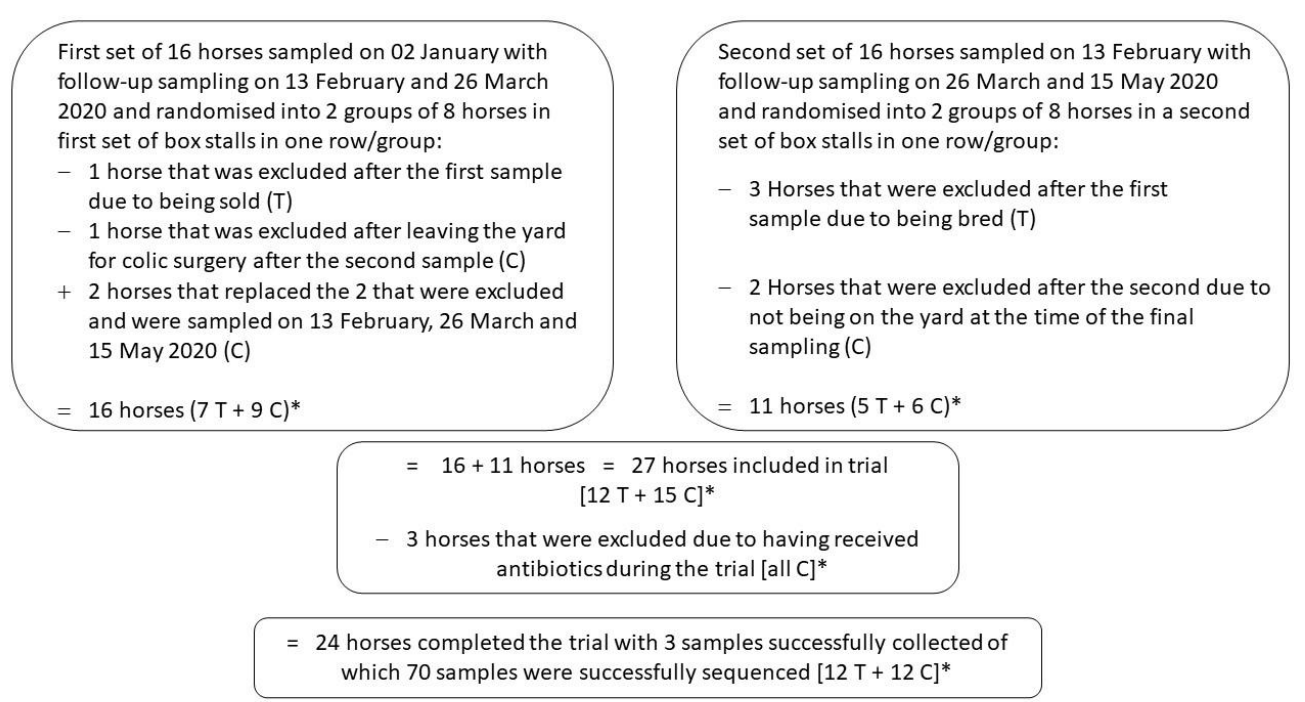
Figure 1. Flow chart of horses enrolled in the clinical trial. * Treatment group assignment was not revealed until after the outcome was assessed.